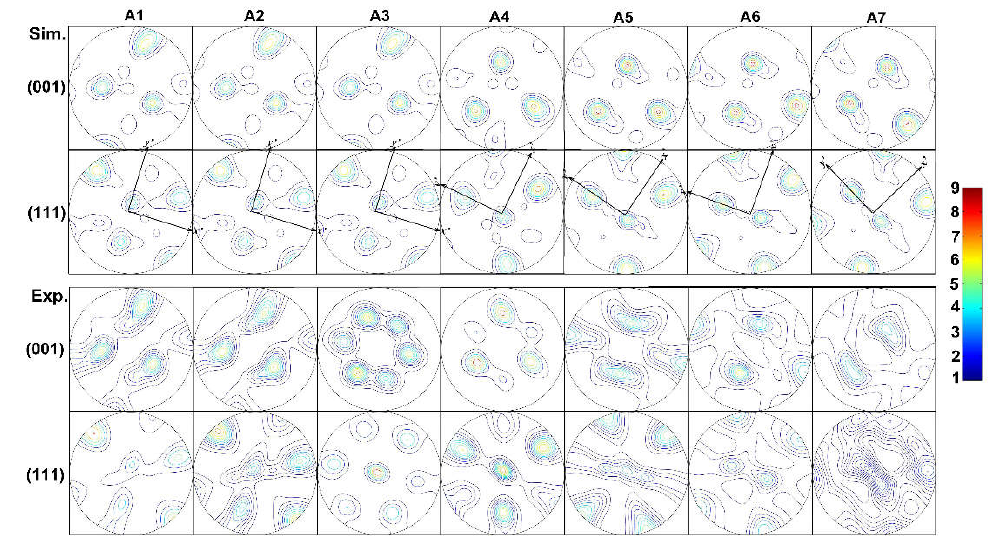
Figure 10. Experimental and Simulated {001} and {111} pole figures along the flow line A.